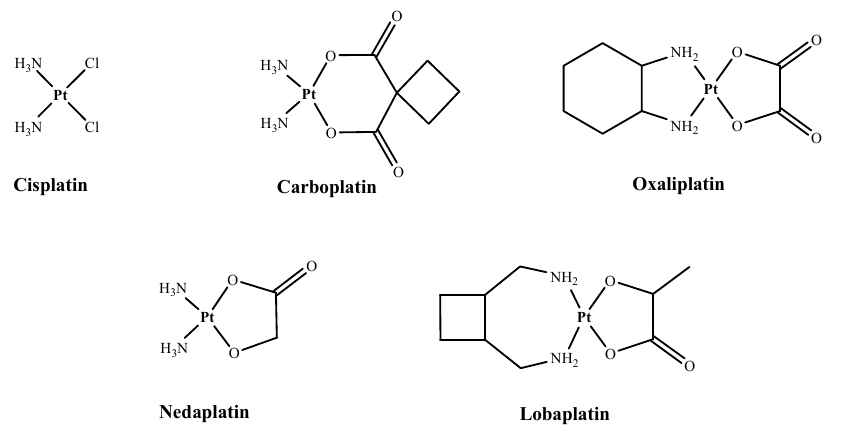
Figure 1. Structure of the clinically approved platinum complexes.